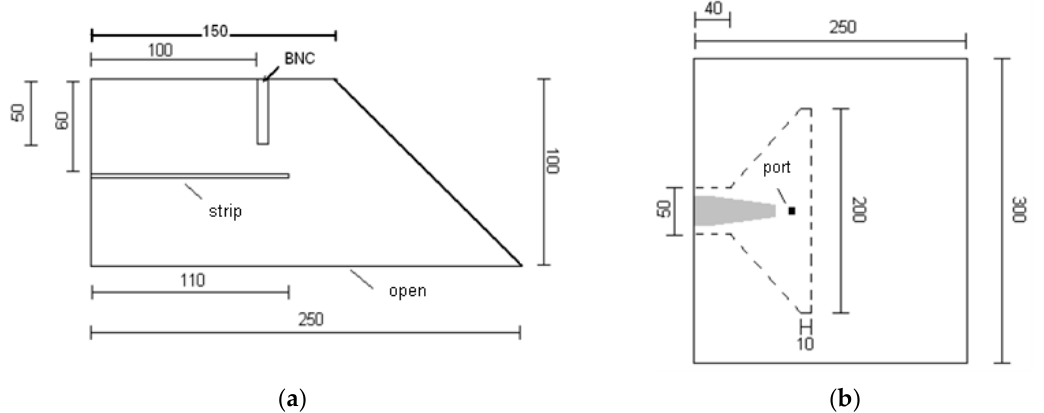
Figure 1. ( a ) Side view of a resonator half; ( b ) top view of a resonator half. Dimensions are in millimeters.